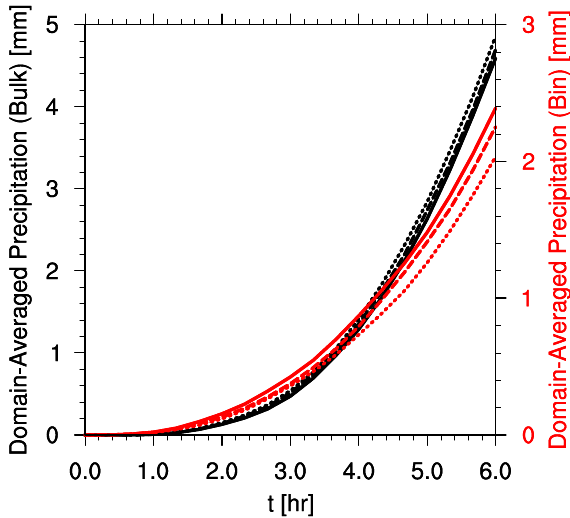
Fig. 9. Same as in Fig. 3 except for the lowRH simulations.